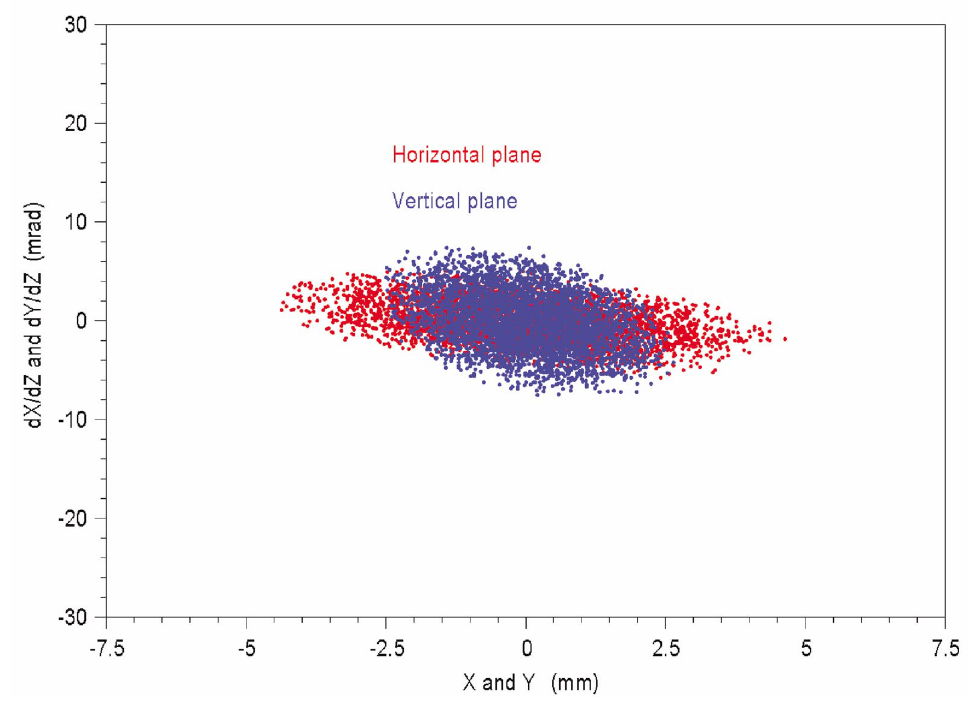
FIG. 24. (Color) Final phase portrait at the linac exit.